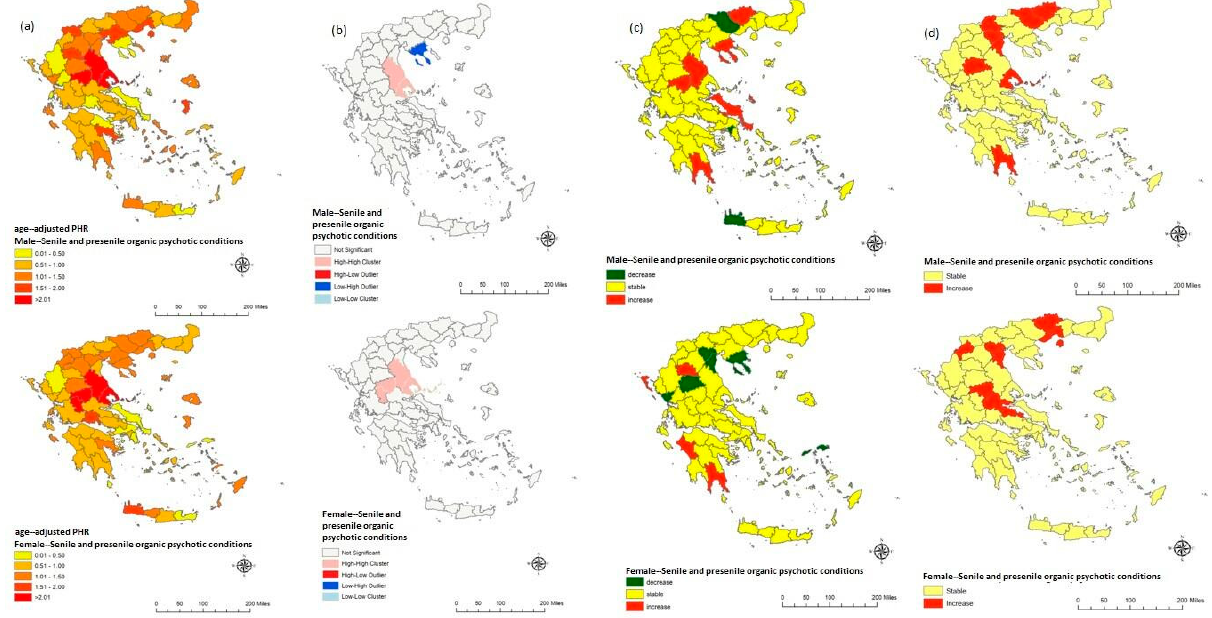
Figure 3 . Descriptive ( a ), LISA ( b ) time series of annual PHR values ( c ) and hospitalization-days ( d ) maps per sex for hospitalizations of patients with senile and presenile organic psychotic conditions from 1999 to 2012 in Greece.